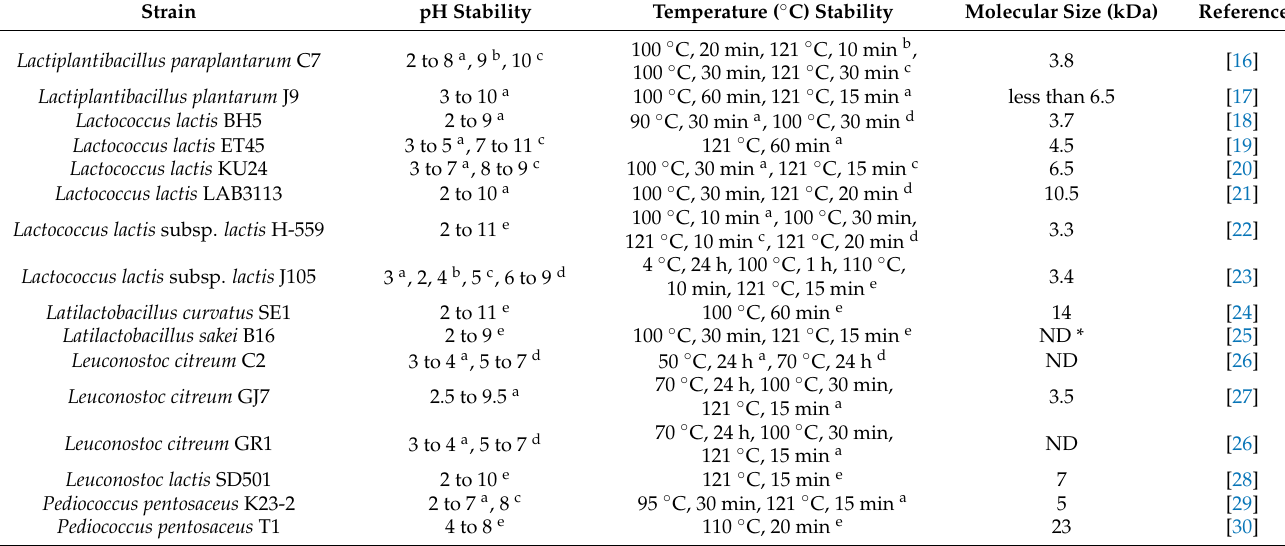
Table 1. Properties of selected bacteriocins produced by LAB isolated from